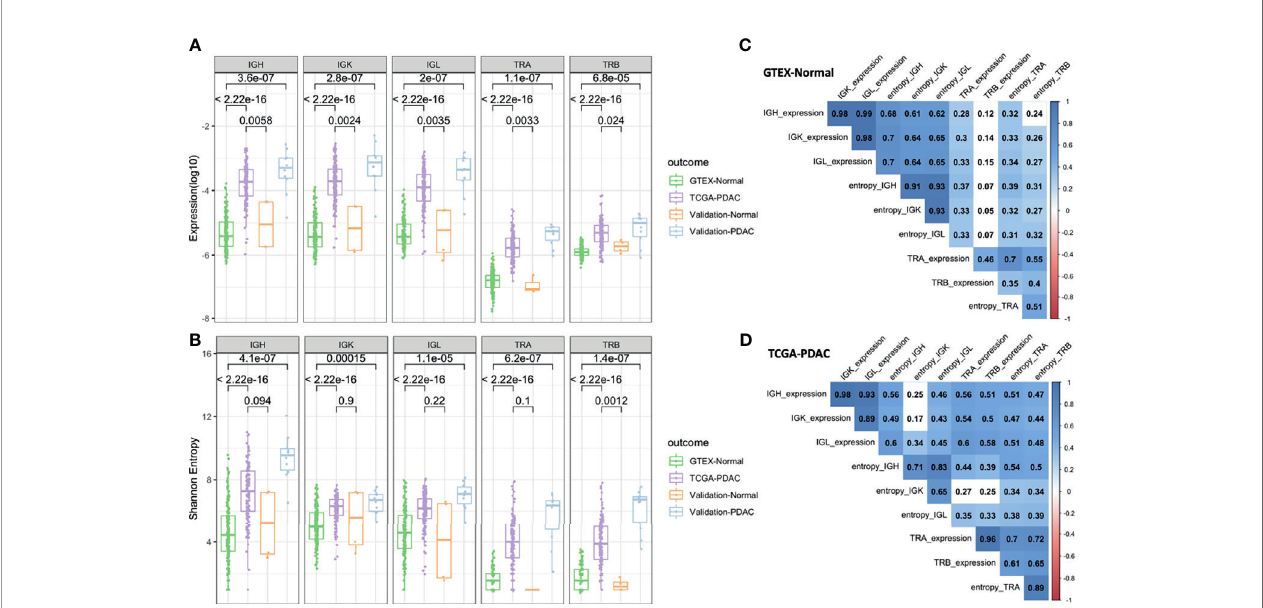
FIGURE 2 | Diversity analysis. Boxplots showing IGH, IGK, IGL, TRA, and TRB expression (A) and Shannon entropy (B) . The p -values correspond to the statistical differences by applying a Wilcoxon test. Correlation plot for the GTEx-normal dataset (C) and TCGA-PDAC dataset (D) . The numbers correspond to the Pearson coef fi cient and the colored ones are statistically signi fi cant (FDR <